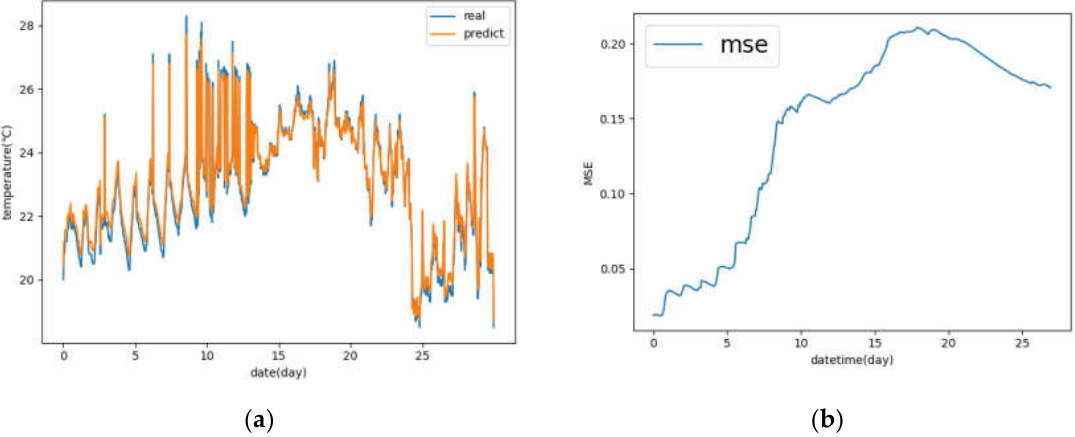
Figure 11. Predicted results of temperature for 30 consecutive days. Figure ( a ) is a graph of the actual temperature and the predicted temperature, and Figure ( b ) is the mean square error of the actual temperature and the predicted temperature.